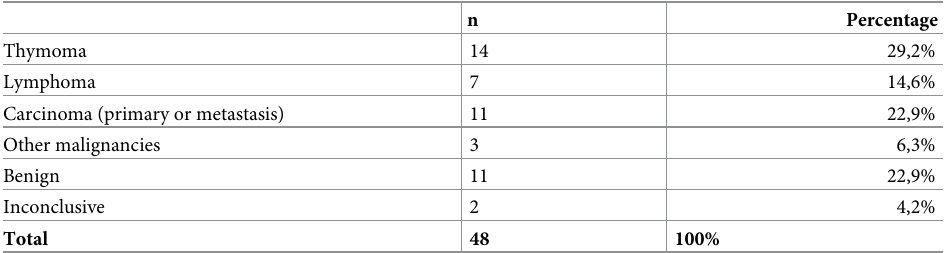
Table 3. Histological analysis of the